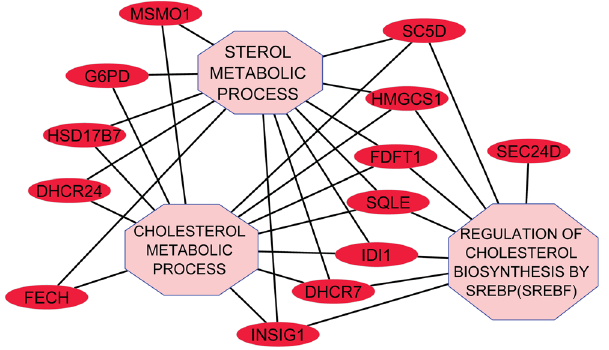
Figure 3. Network of down regulated genes involved in several aspects of cholesterol/sterol